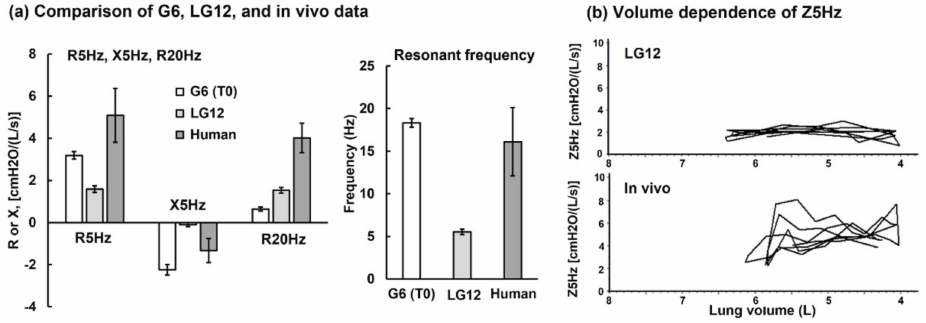
Figure 7. Effect of the lung model complexity: ( a ) comparison of the IOS outputs (R5Hz, X5Hz, R20Hz, and resonant frequency) from G6 (T0) and G12 to in vivo IOS measurements (i.e., human) from Williamson et al. [45], who measured 24 healthy subjects aged 24 − 28 years old; ( b ) volume dependence of the impedance Z5Hz for the lung casts (LG12) and a normal human subject in our